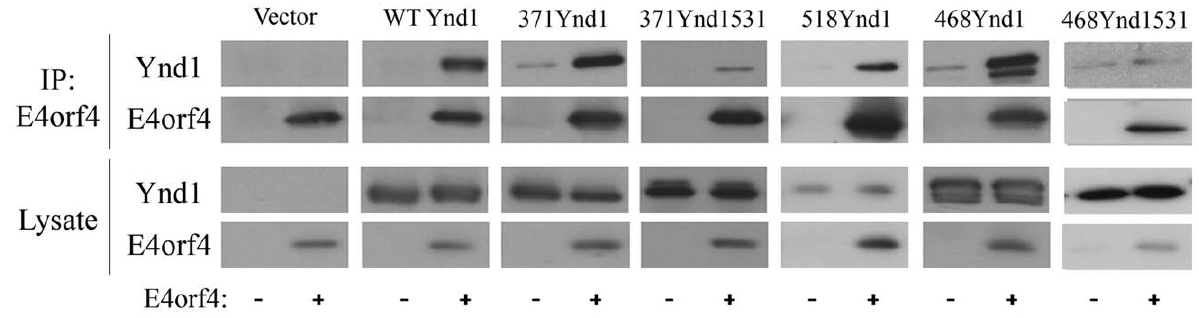
Figure 4. Coimmunoprecipitation of E4orf4 with WT and mutant Ynd1 proteins. E4orf4 was immunoprecipitated from ynd1 D yeast cells expressing the indicated Ynd1 proteins. Western blots of the immune complexes (IP) and input lysates (10% of IP) were stained with the indicated antibodies.